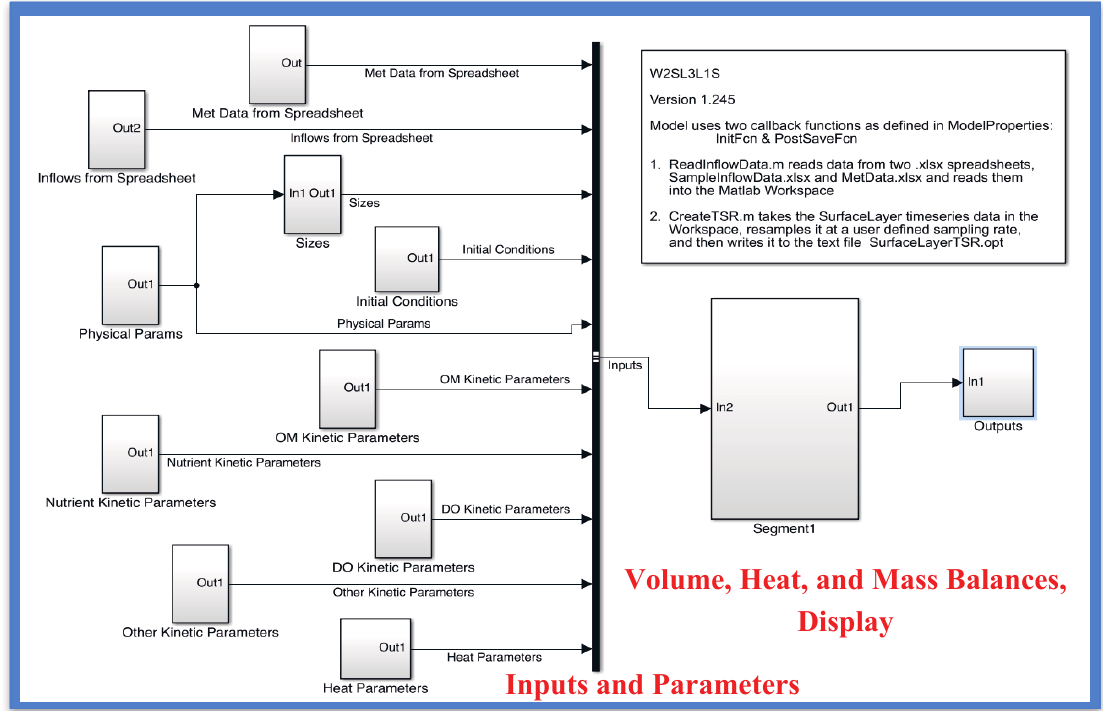
Figure 6. Uppermost system in the one-segment 3-layer water quality (W2SL3) model executed in Simulink. Each box is a separate subsystem for setting inputs and parameters (left) or solving volume, heat, and mass balances (right). Lines and arrows indicate data transfers between